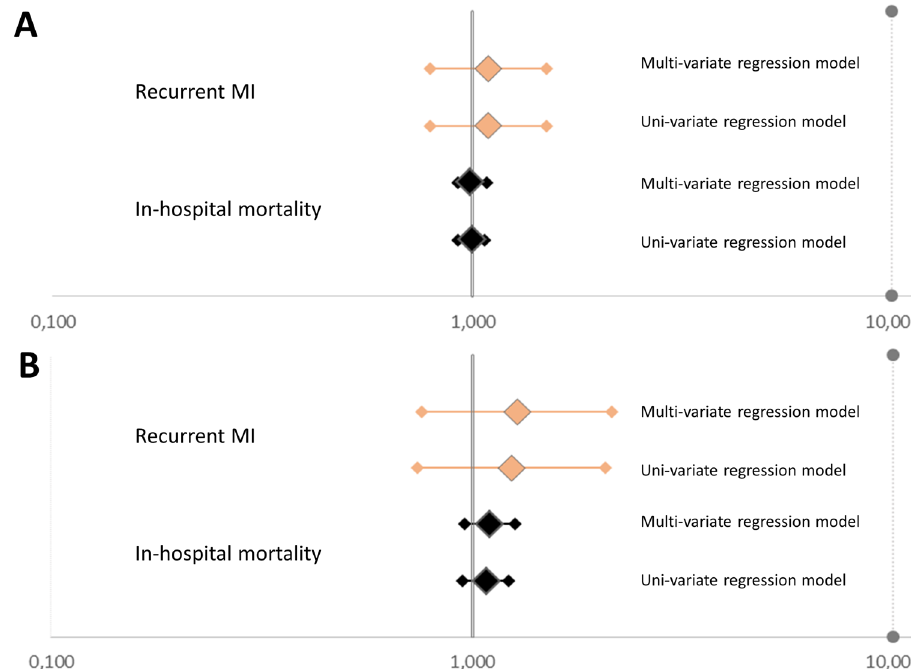
Figure 1. Impact on in-hospital mortality and recurrent MI. Logistic regression analyses for associations between the soccer world cup as well as the games of the German national team on recurrent MI and in-hospital mortality. ( A ) Impact of the soccer world cup 2014 on the outcomes recurrent MI and in-hospital mortality compared to the comparison-period 2015. ( B ) Impact of the German national team soccer games on the outcomes recurrent MI and in-hospital mortality compared with the other days of the world cup